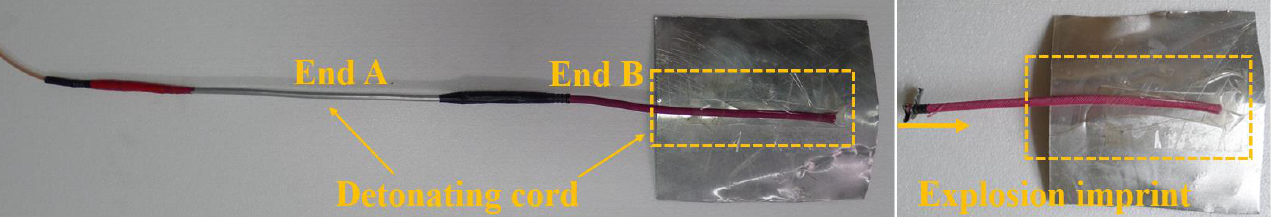
Figure 8. Successful explosion-proof experiments.